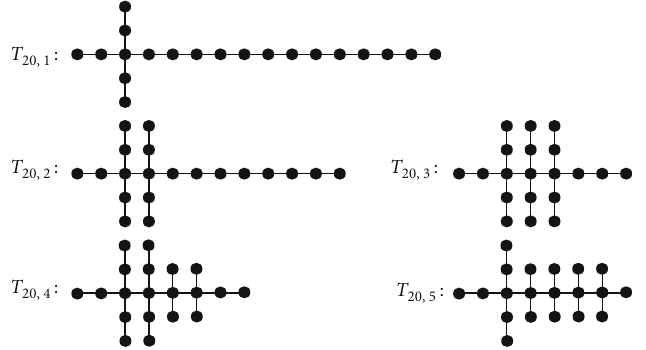
Figure 1: Five trees in the class of 1 T